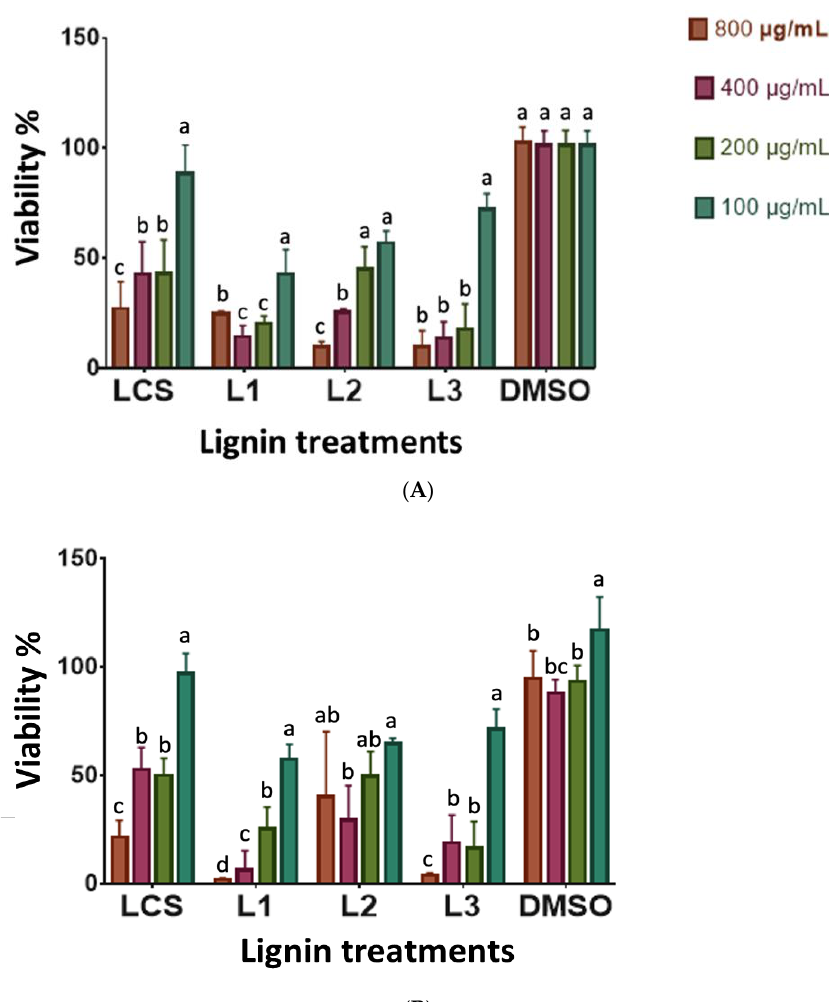
Figure 6. Antimicrobial activity of sorghum lignin extracts without treatment (LCS) and with different treatments (L1) Lignin treatment time/amplitude-10/20. (L2) Lignin treatment time/amplitude-10/18. (L3) Lignin treatment time/amplitude-10/14 vs. growth curve of ( A ) S. aureus ATCC 25923 and ( B ) E. coli ATCC 25922. DMSO was used as the solvent control. The results are representative of at least three independent experiments. Different letters indicate significant difference ( p < 0.05).